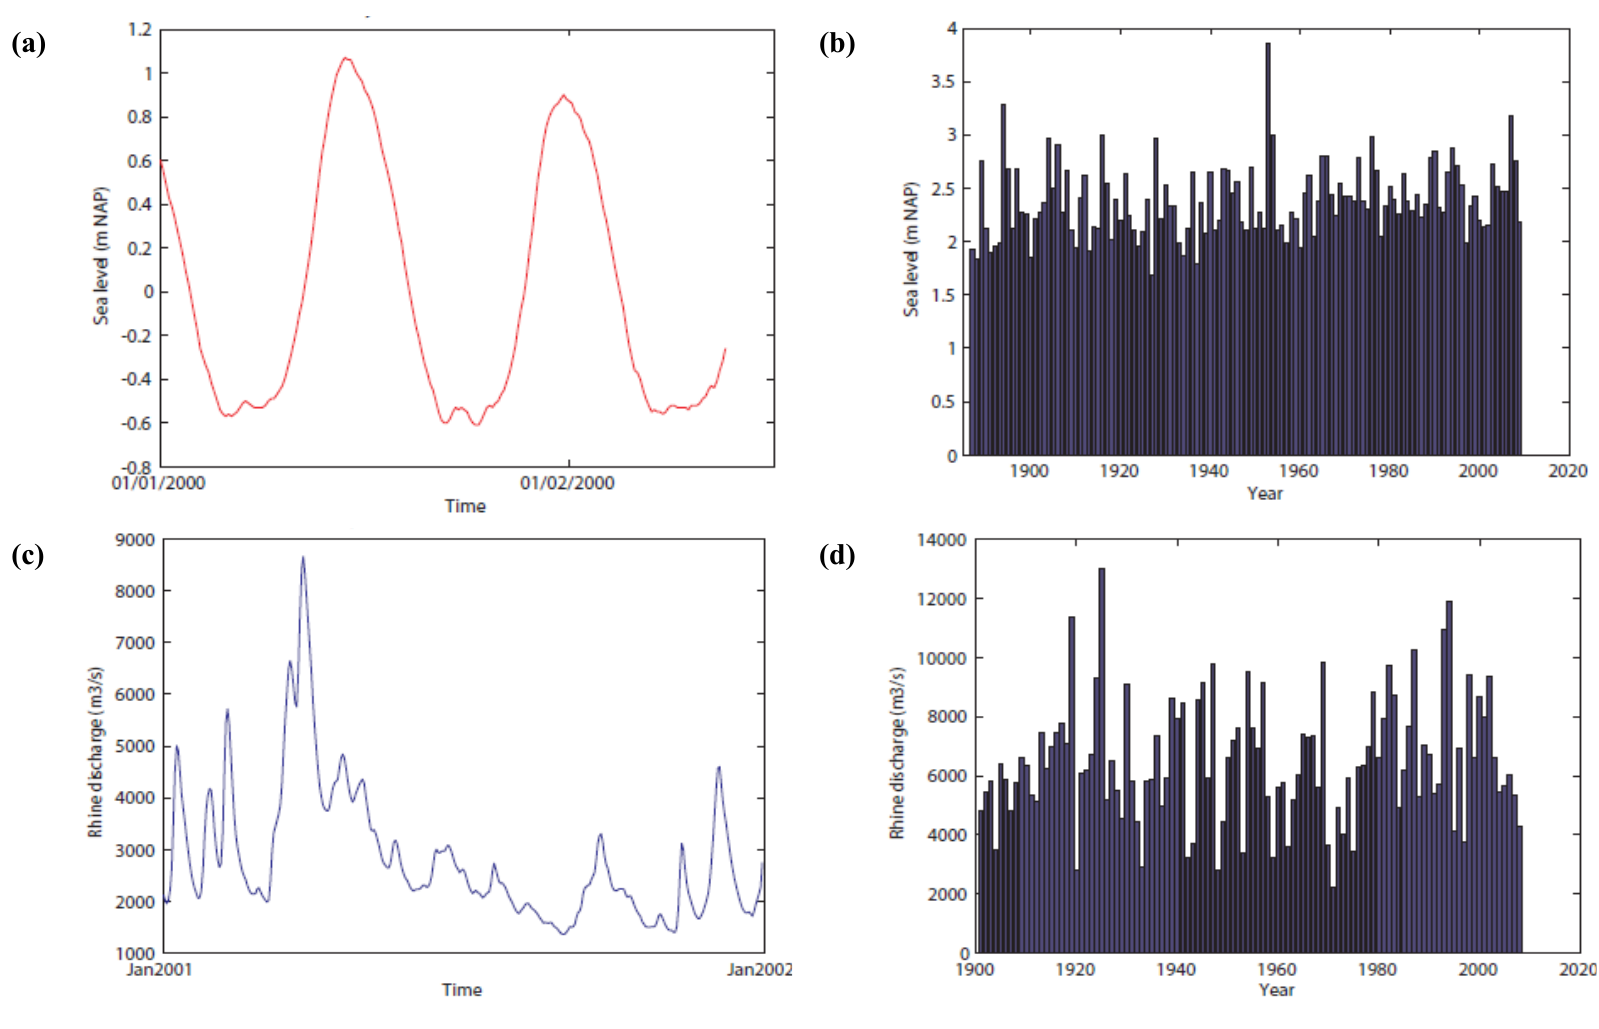
Figure 2. ( a ) One day sea level in Hook of Holland; ( b ) Annual maximum sea level in Hook of Holland; ( c ) One year Rhine discharge in Lobith; ( d ) Annual maximum Rhine discharge in